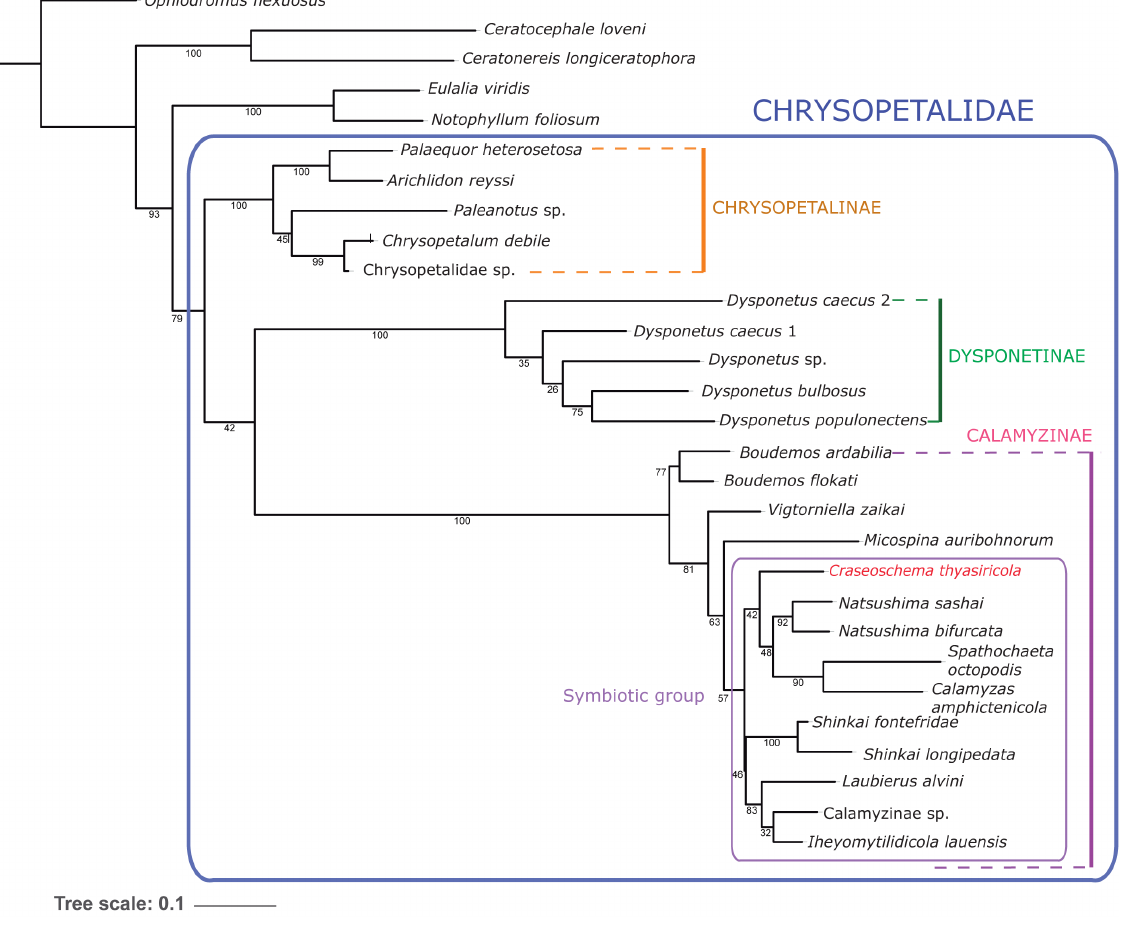
Fig. 2. Maximum likelihood tree of the concatenated data set, including the genes COI, H3, 16S and 18S. Bootstrap support values are shown below the